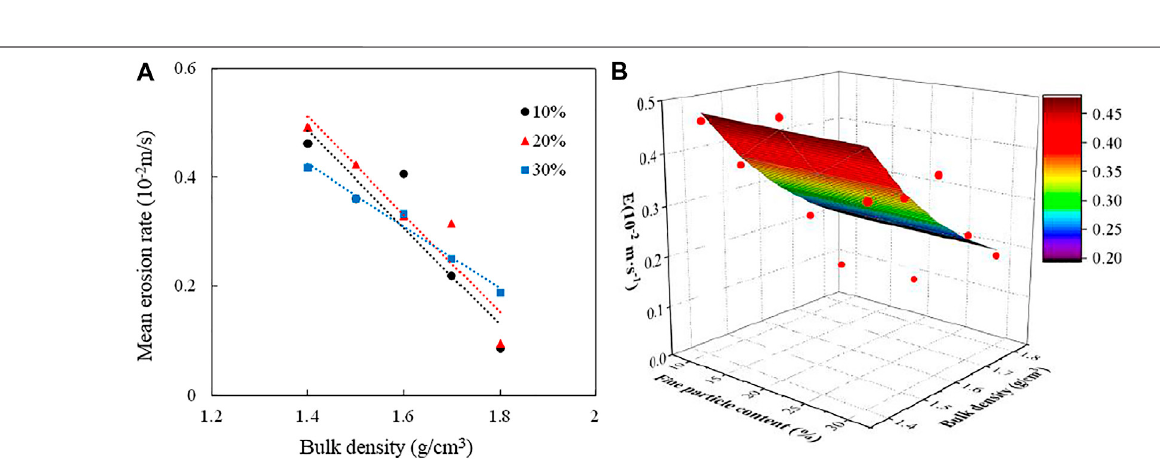
Frontiers in Earth Science |